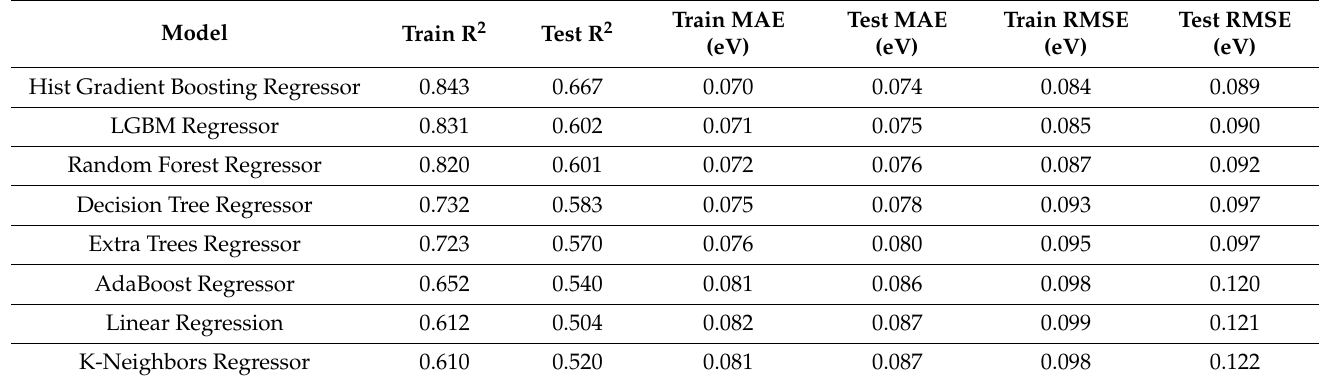
Table 4. R 2 , mean absolute error (MAE) and root mean square error (RMSE) values for LUMO prediction.